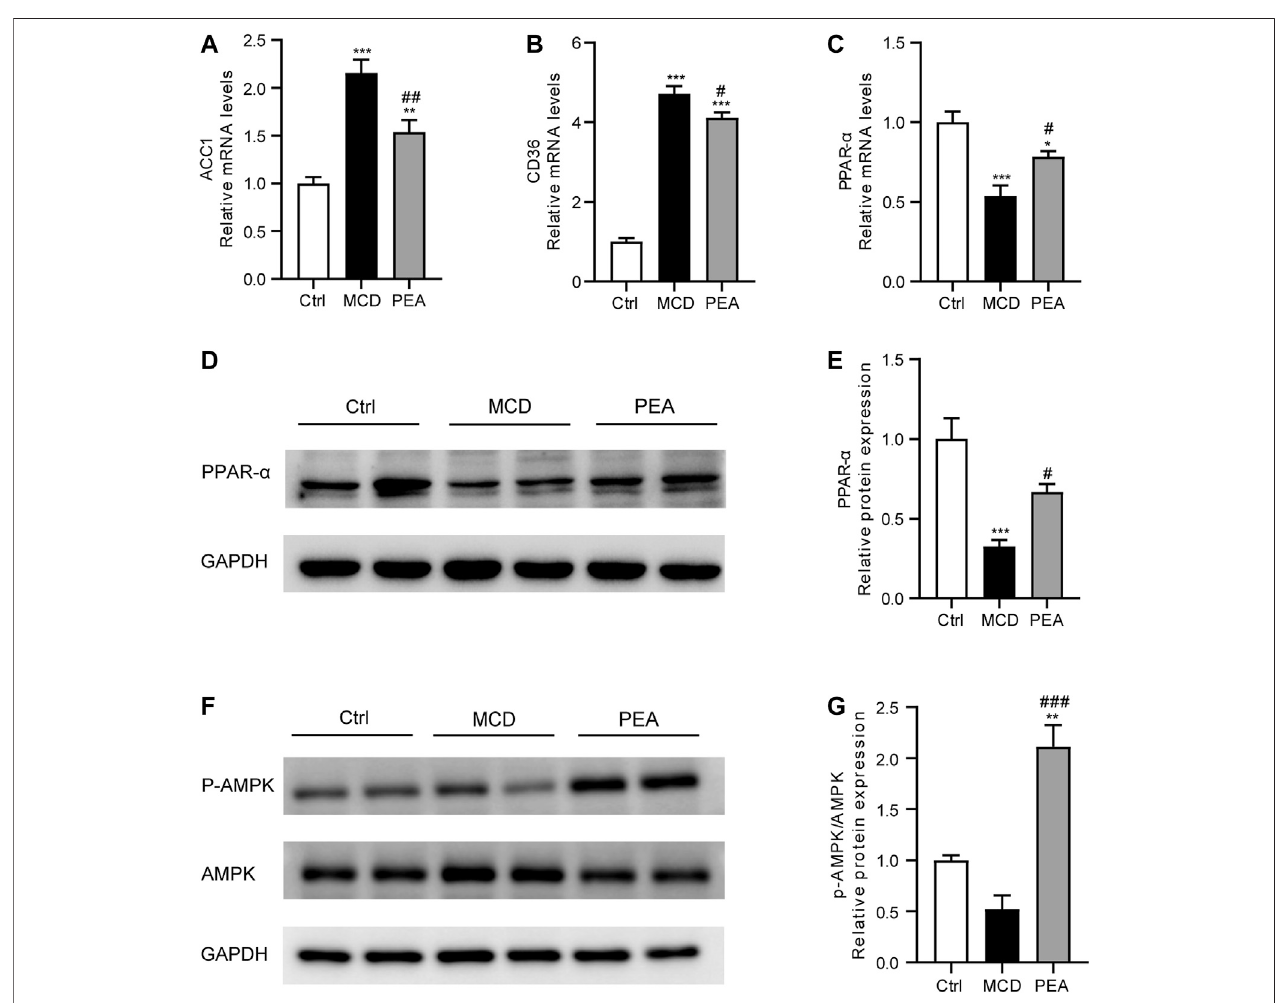
FIGURE 2 | Effect of PEA on ACC1, CD36, PPAR- α and AMPK expression. (A) ACC1, (B) CD36, and (C) PPAR- α mRNA expression in the liver. (D – E) Hepatic PPAR- α protein levels were examined and quanti fi ed via western blotting. (F – G) Western blot determined p-AMPK and AMPK protein levels in the liver. Ctrl: the mice treatedwithstandarddiet;MCD: themicetreatedwithMCDdiet;PEA:themicetreatedwithMCDdietandPEA.Values wereexpressed asthemean ± SEM, n (cid:1) 6 – 8for each group. * p < 0.05, ** p < 0.01, *** p < 0.001 versus the Ctrl group; # p < 0.05, ## p < 0.01 versus the MCD group.